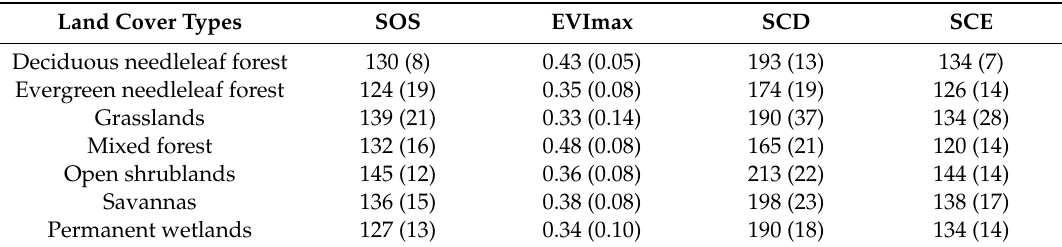
Table A3. Average and standard deviation (in brackets) of the start of the growing season (SOS, in Julian days), annual maximum EVI (EVI max ), snow cover duration (SCD, days), and snow cover end date (SCE, in Julian days) for di ff erent land cover types.